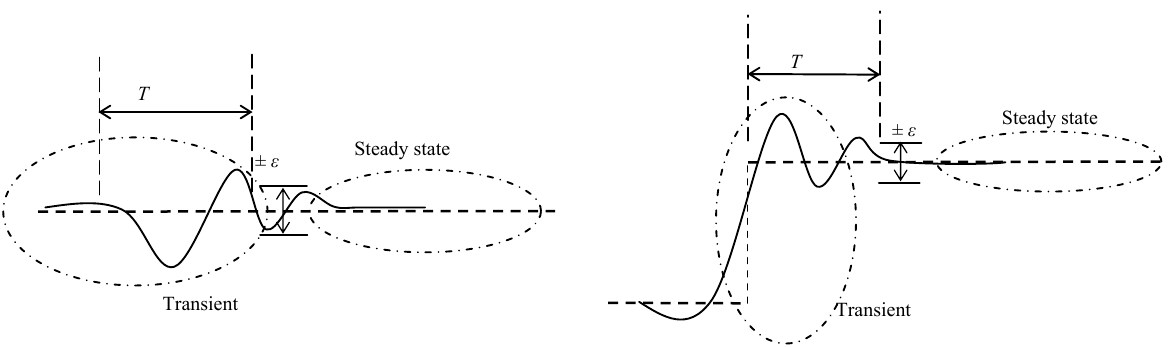
Figure 4. Power reference profile and generated power.